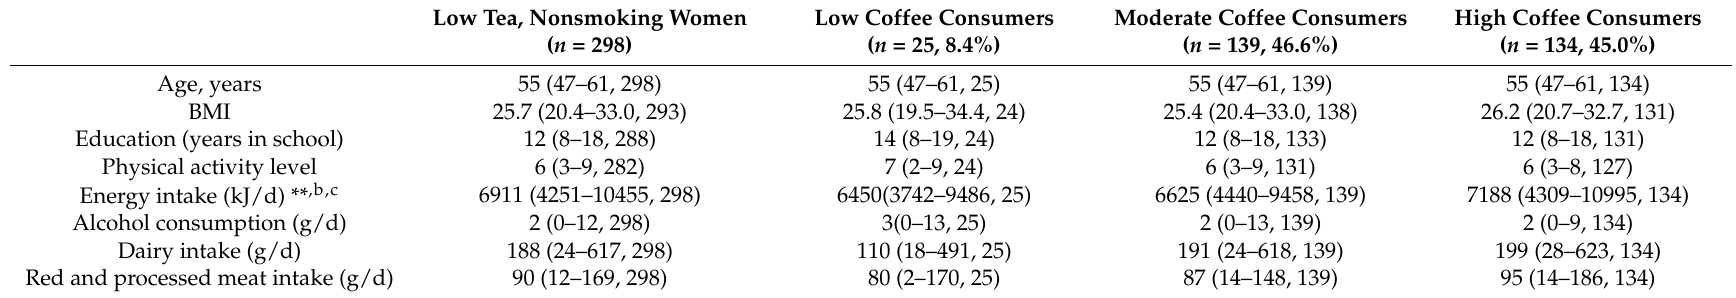
Table 2. Descriptive statistics of “low tea, nonsmoking women,” low coffee consumers, moderate coffee consumers, and high coffee